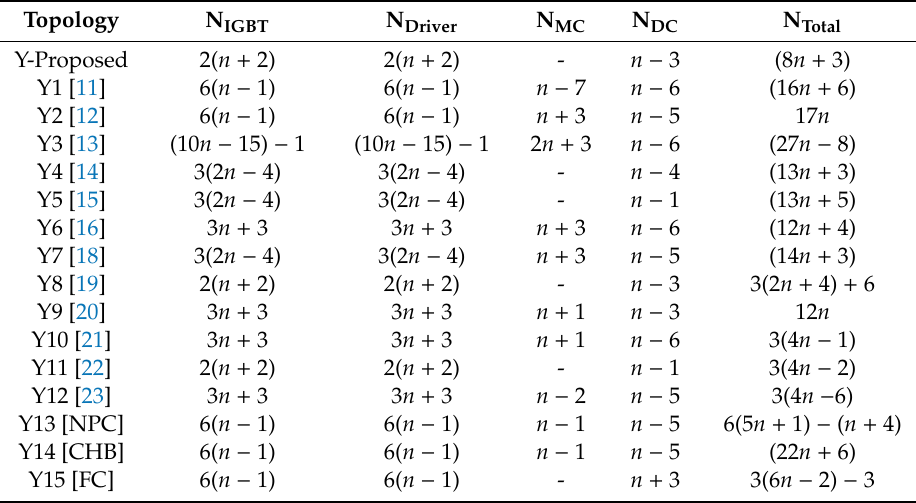
Table 3. Comparison Based